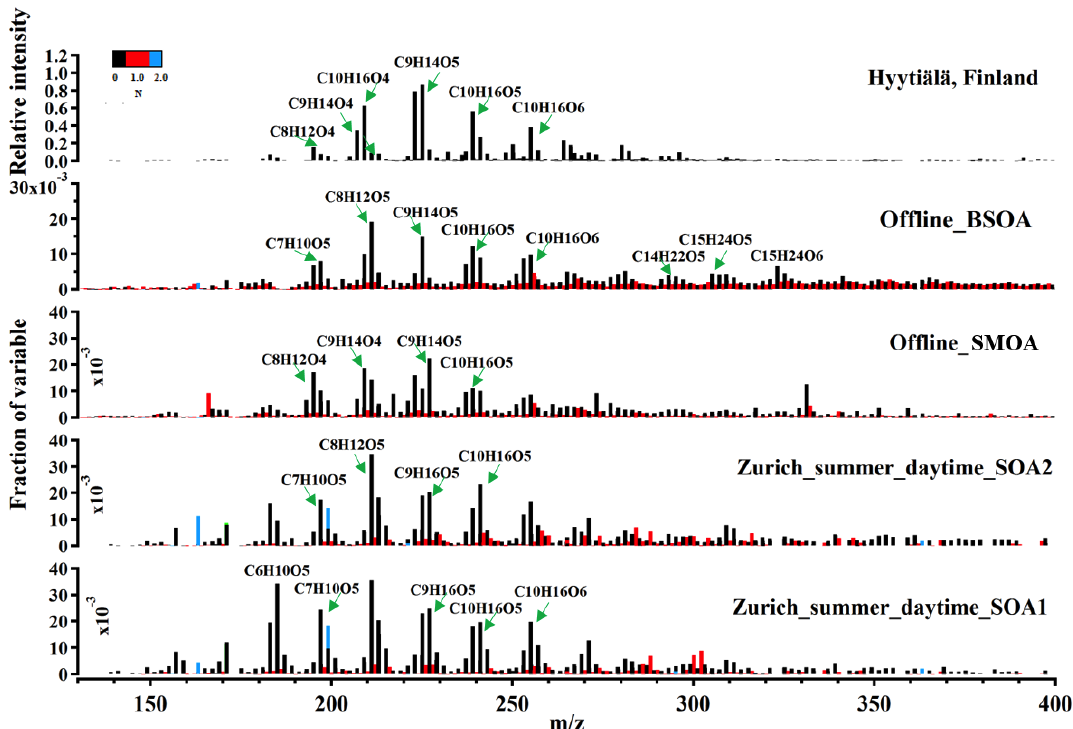
Figure 8. Comparison of the offline summer factor profiles with mass spectra from the Hyytiälä field campaign and the online summer factors. The total signal of each factor is normalized to